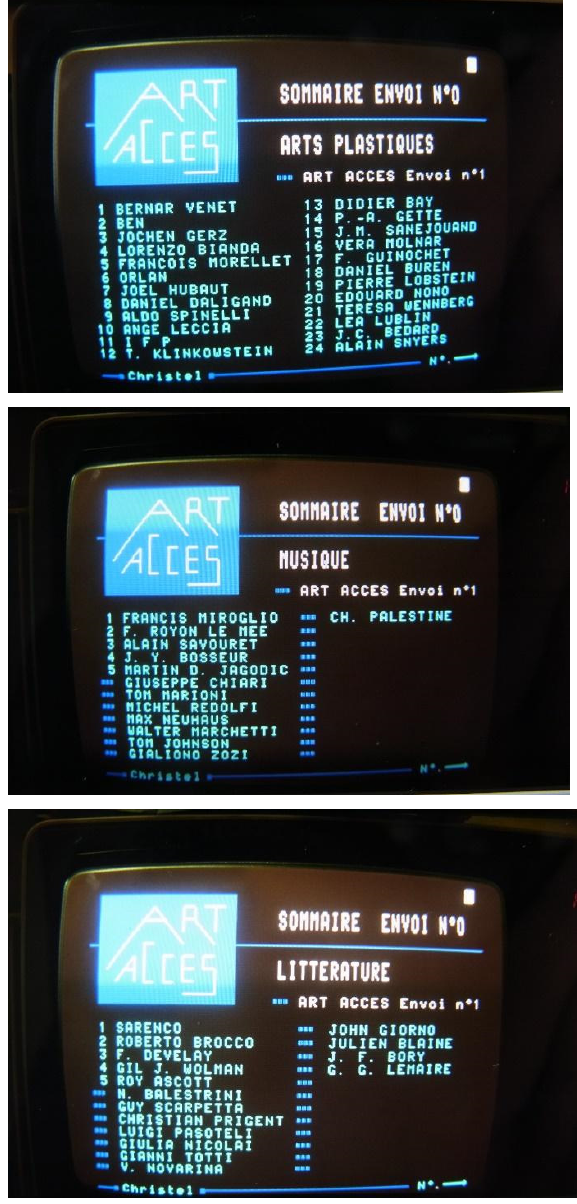
Figure 1. Images of the summaries of the three sections “Visual Arts”, “Literature” and “Music” of the Art Accès issue no. 0. Collection Frédéric Develay © Kandinsky Library, MNAM/CCI, Centre Pompidou, photos: Andreas Broeckmann.